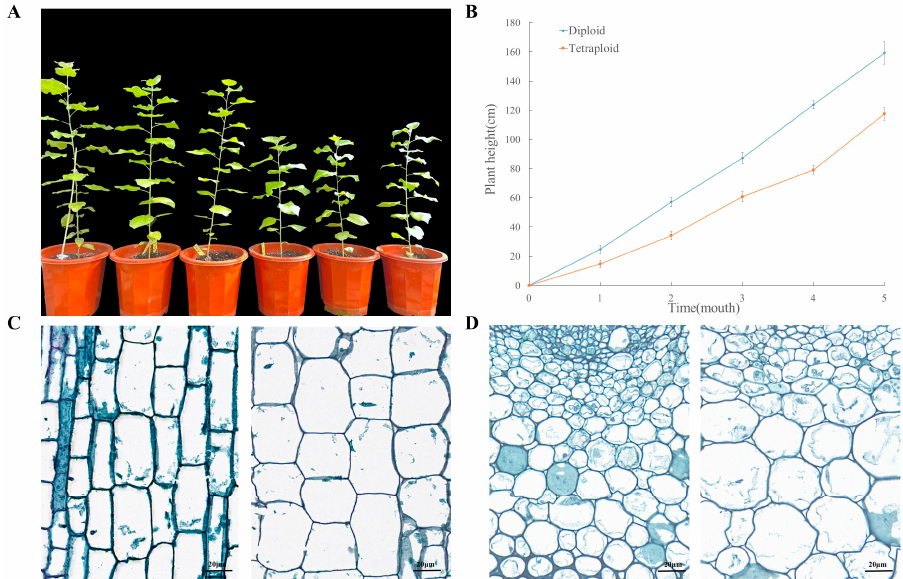
Figure 1. Comparison of plant height and anatomical characteristics of diploid and tetraploid poplar 84K. ( A ) Phenotype of tetraploids and diploids after 3 months. ( B ) Average growth rates (height) between tetraploids and diploids during time. ( C ) Longitudinal sections of the diploid (left) and tetraploid (right) stem internodes. ( D ) Transverse sections of the diploid (left) and tetraploid (right) leaves.